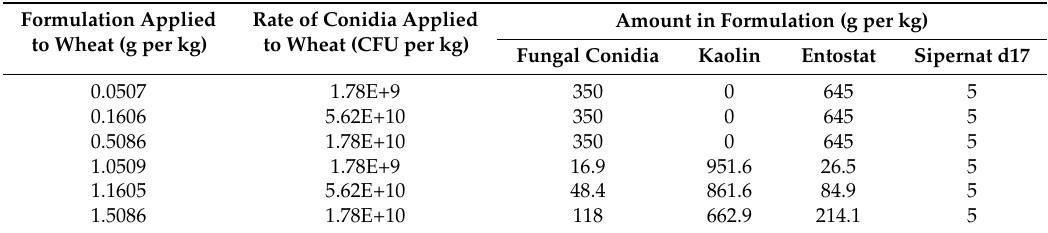
Table 1. Details of the application rates and quantities of formulation components used in the Sitophilus granarius bioassay (bioassay